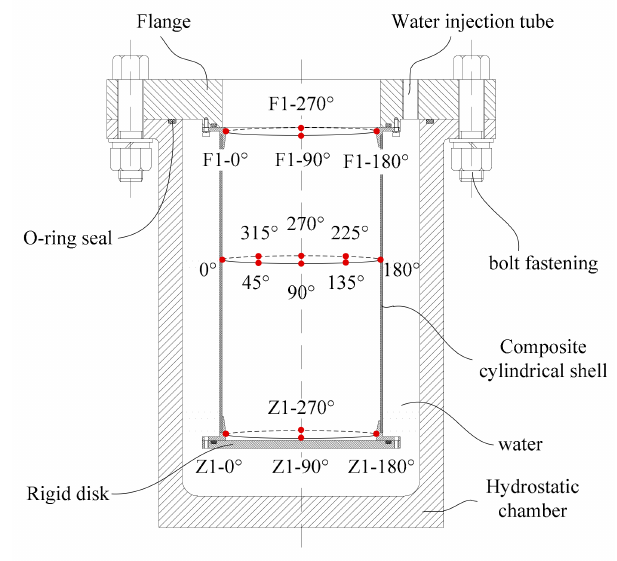
Figure 2. Test set-up and locations of strain gauges.